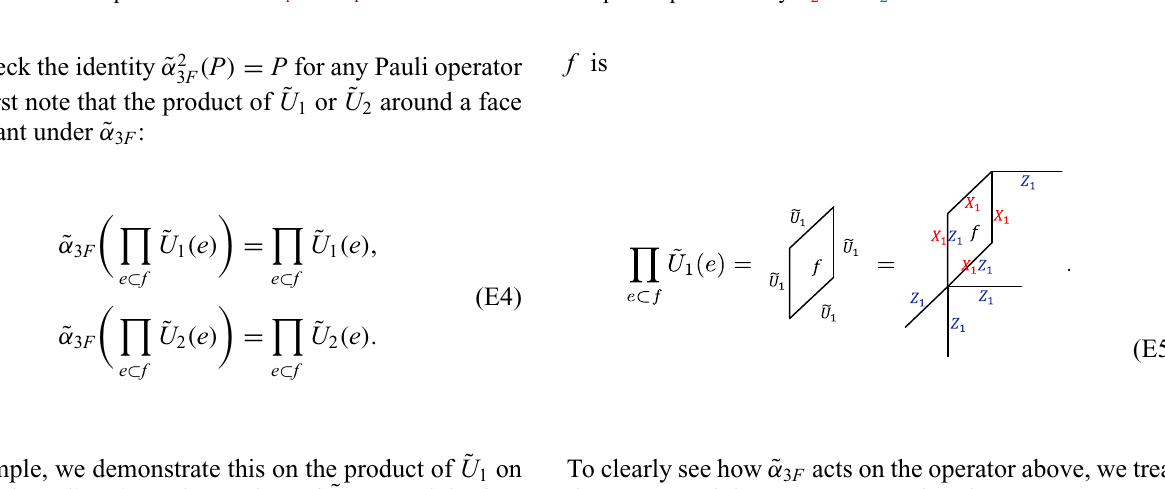
FIG. 6. The locally flippable separators used to define the QCA ˜ α 3 F . There are two qubits per edge with the Pauli- X and Pauli- Z